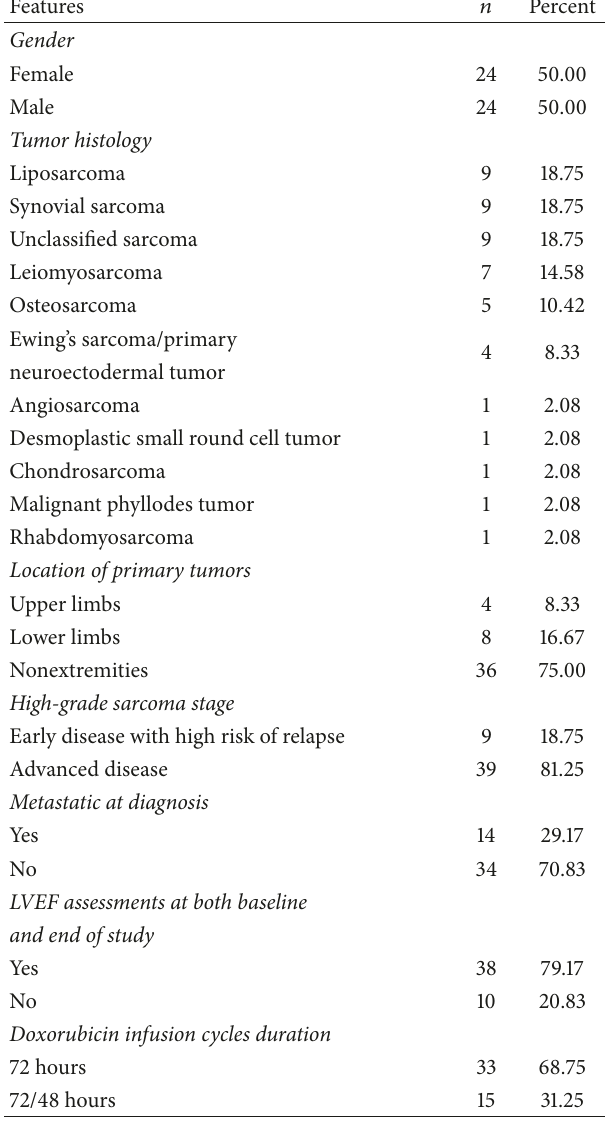
Table 1: Patient and treatment